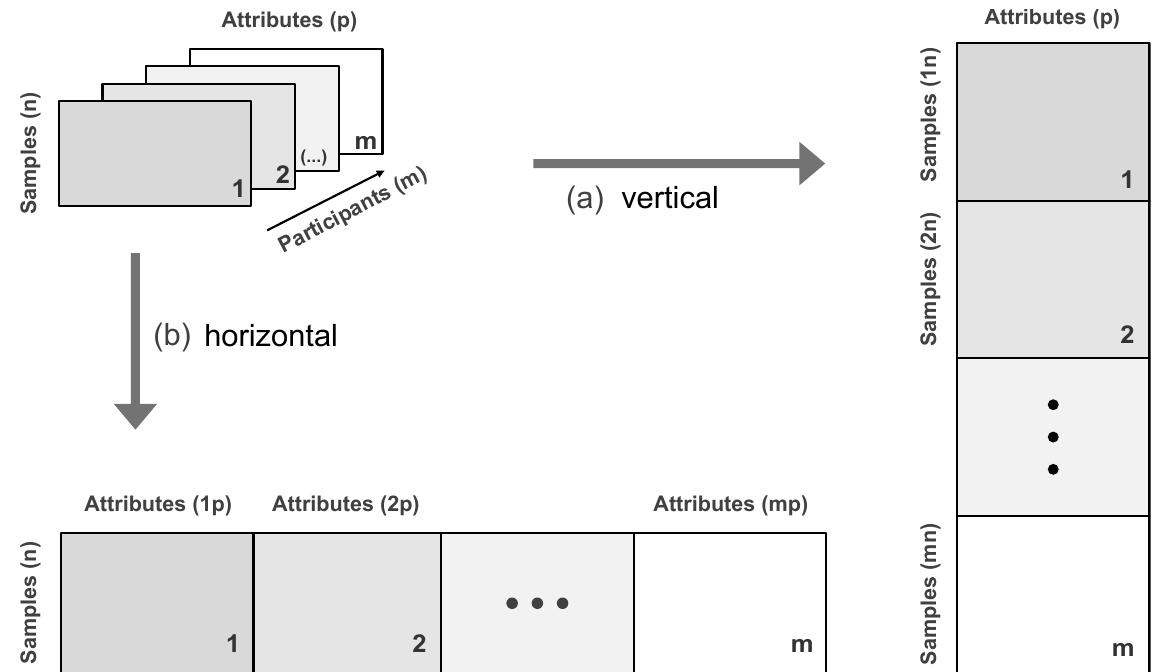
Figure 4. Three-way matrix unfolding . The figure depicts the two unfolding strategies used in Tucker-1 analysis. The three-way dataset is arranged either (a) vertically as an ( mn × p ) matrix or (b) horizontally as an ( n × mp ) matrix, resulting in unique sample–participant or participant–attribute pairs. This forms the foundation for the agreement (consonance) analysis, where participants with similar perceptions of samples (a) cluster together in the principal component space and participants with similar perceptions of attributes or (b) cluster together